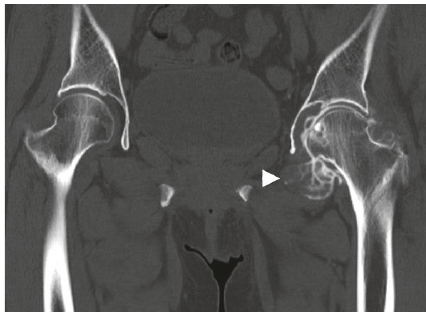
Figure 3: Arthro-computerised tomography scan of the left hip joint. The extra-articular herniation sac is indicated by the arrow- head.